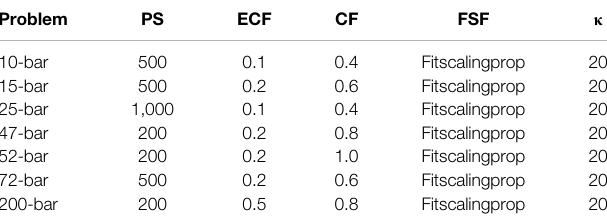
TABLE 5 | Optimized values for the control parameters.